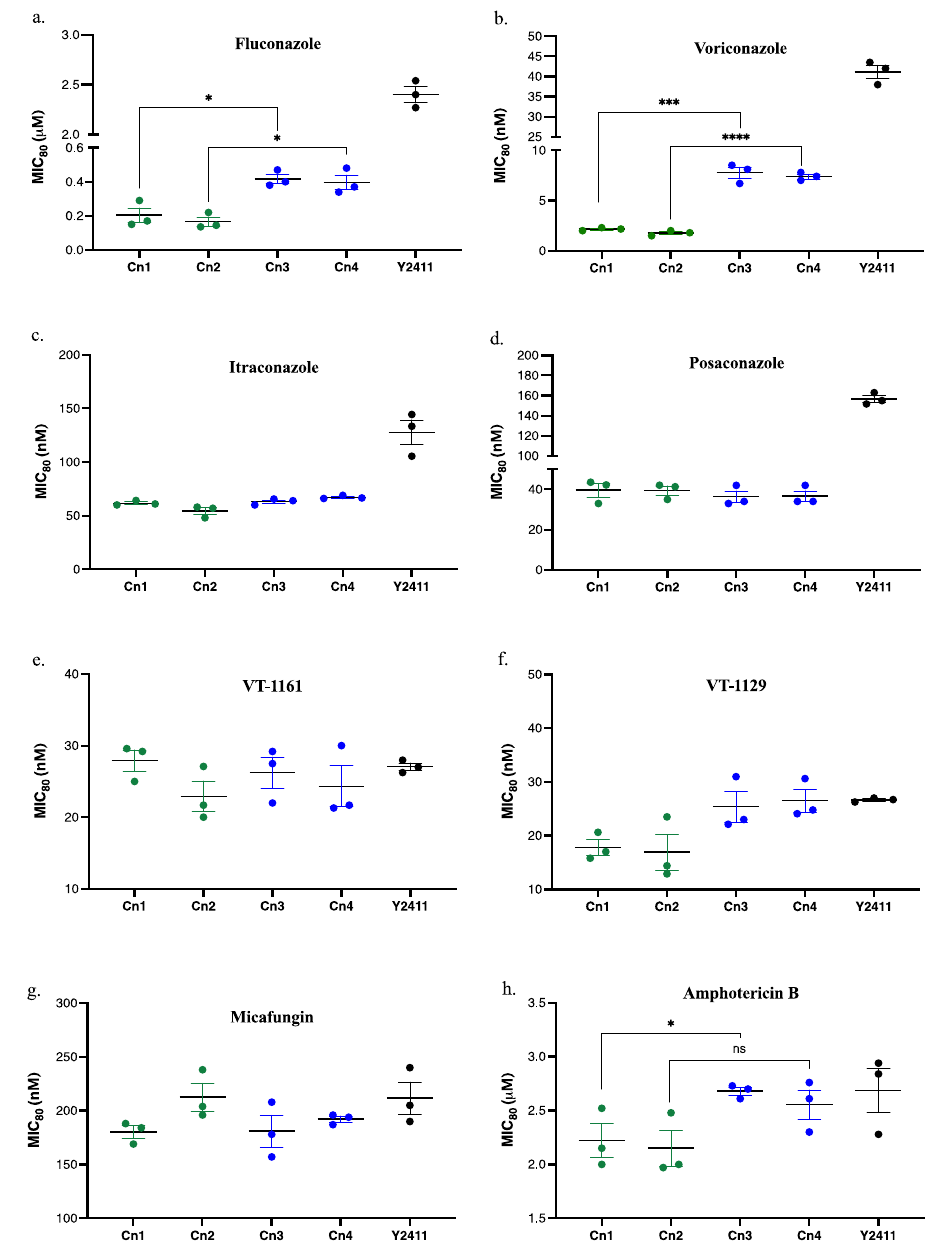
Figure 2. Susceptibilities of strains Cn1–Cn4 and Y2411 to azole antifungals. ( a ) FLC, ( b ) VCZ, ( c ) ITC, ( d ) PCZ, ( e ) VT-1161, ( f ) VT-1129, ( g ) MCF, ( h ) AmpB. Glucose-containing SD medium buffered at pH 6.8 was used. The MIC 80 values were determined in microtiter plates from the OD 600nm values compared with no drug controls. The experiments were carried out in triplicates in three separate experiments for each strain and drug. The scatter plot is based on the average MIC 80 values of three individual experiments ( n = 3). The horizontal line at the centre represents the mean MIC 80 and the error bars indicate the standard error of the mean (SEM). An unpaired two-tailed Student’s t -test was used to compare the MIC 80 values of the strains, Cn1 vs. Cn3 and Cn2 vs. Cn4. The statistical significance is shown with an asterisk. * p < 0.05, *** p < 0.001 and **** p < 0.0001. ns—non-significant. The statistical significance values for ITC, PCZ, VT-1129, VT-1161 and MCF were non-significant (not shown on plot).